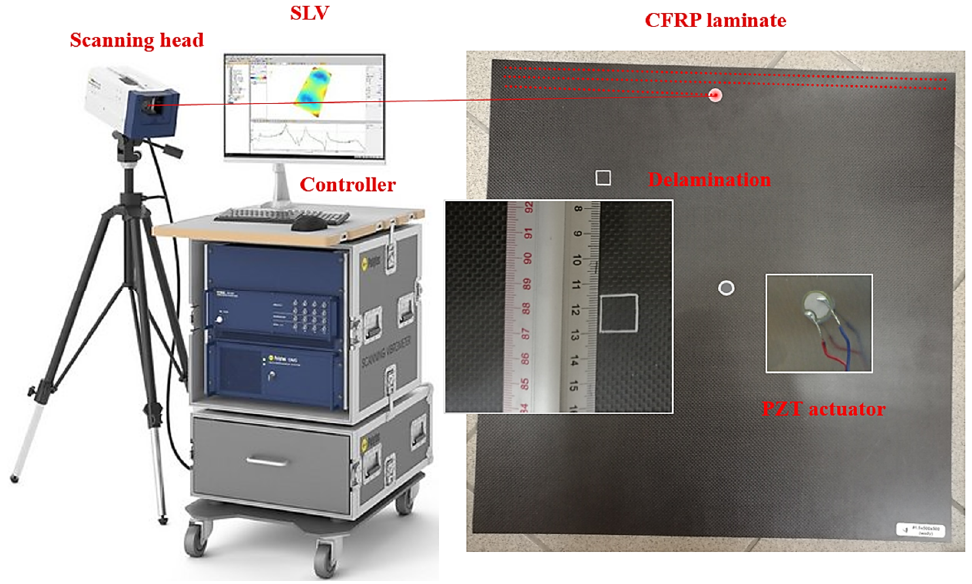
Figure 1. Experimental setup and specimen.